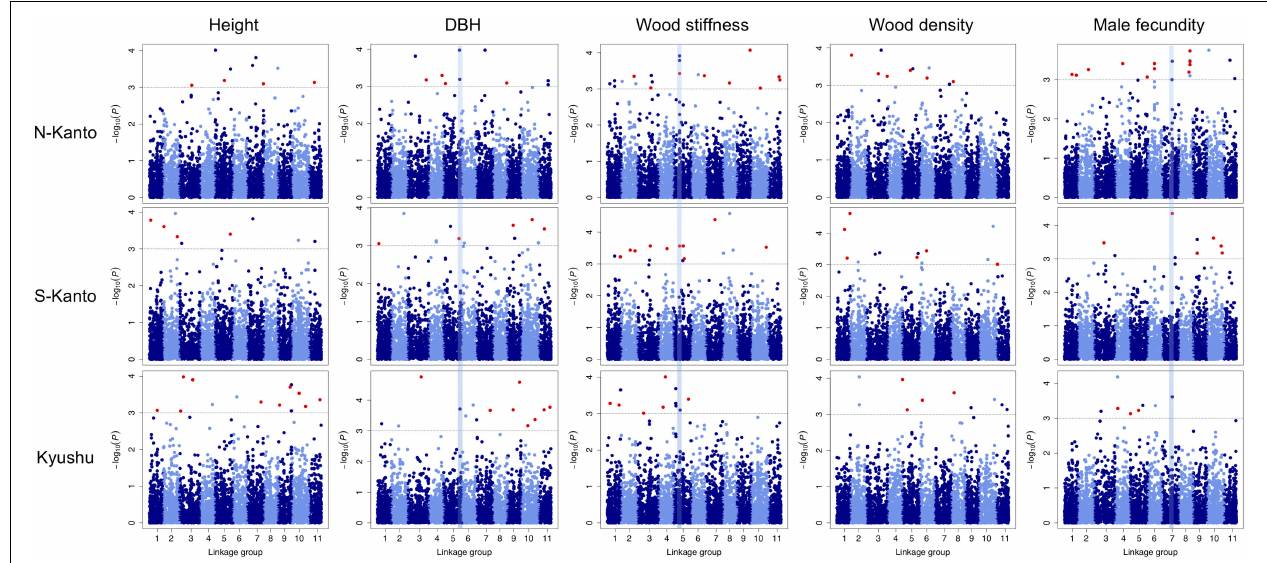
FIGURE 5 | Manhattan plots of GWAS results for the assessed traits in each population. Results for traits of height, DBH, wood stiffness, wood density and male fecundity are shown in columns for the N-Kanto, S-Kanto and Kyushu populations shown in the upper, middle and lower rows, respectively. Vertical blue lines represent the common significant regions shown in Table 2 . Red circles indicate significant SNPs (– log 10 ( P ) > 3) which were unmapped but estimated their positions based on the LD extent with the mapped ones.